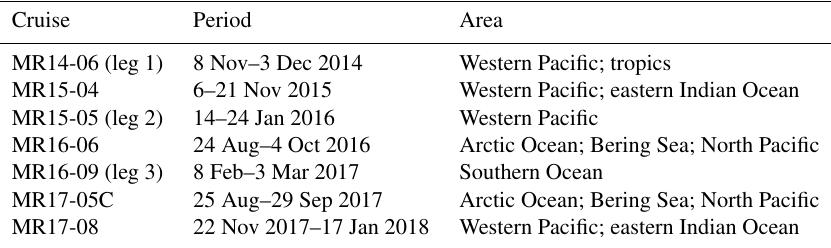
Table 3. Research cruises of the R/V Mirai that generated the data used for this study. Cruise Period